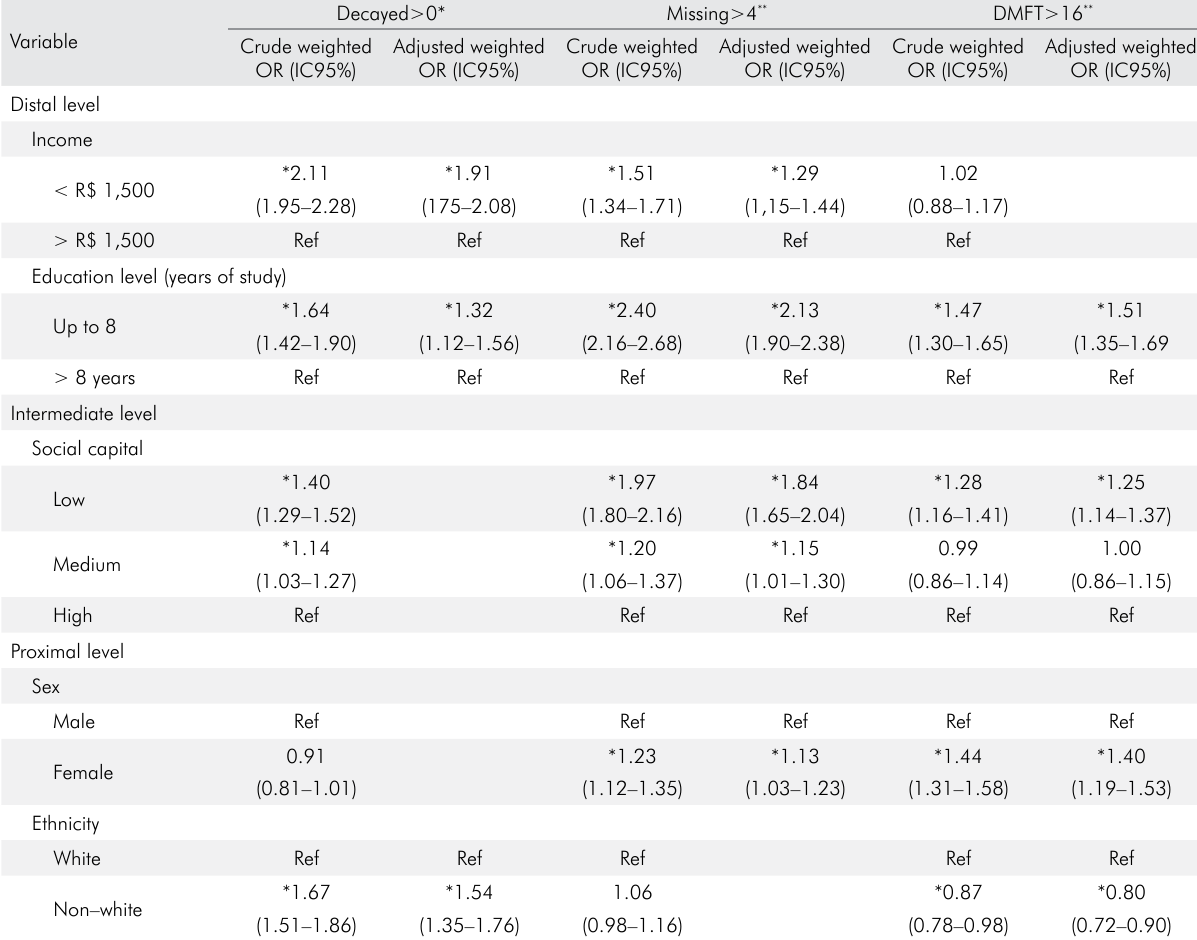
Table 3. Crude and adjusted analyses for the number of decayed and missing teeth, and DMFT regarding the variables analyzed.